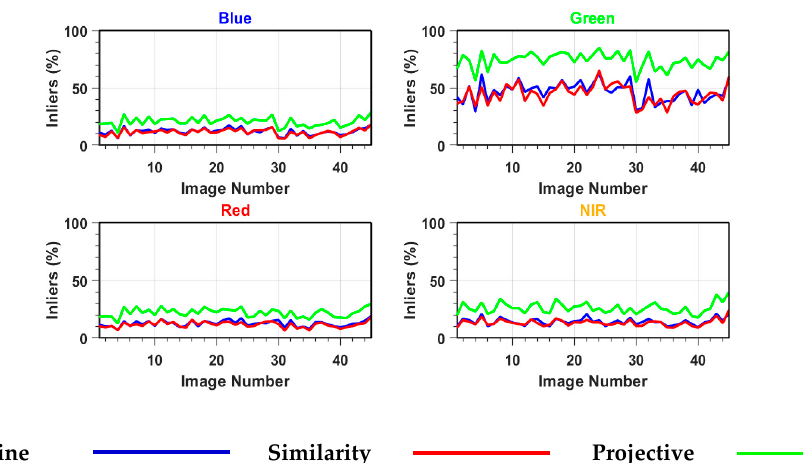
Figure 6. Variation as a function of the image number of the percentage of inliers matching points with respect to the total number of matching points for the MicaSense ® RedEdge blue, green, red,